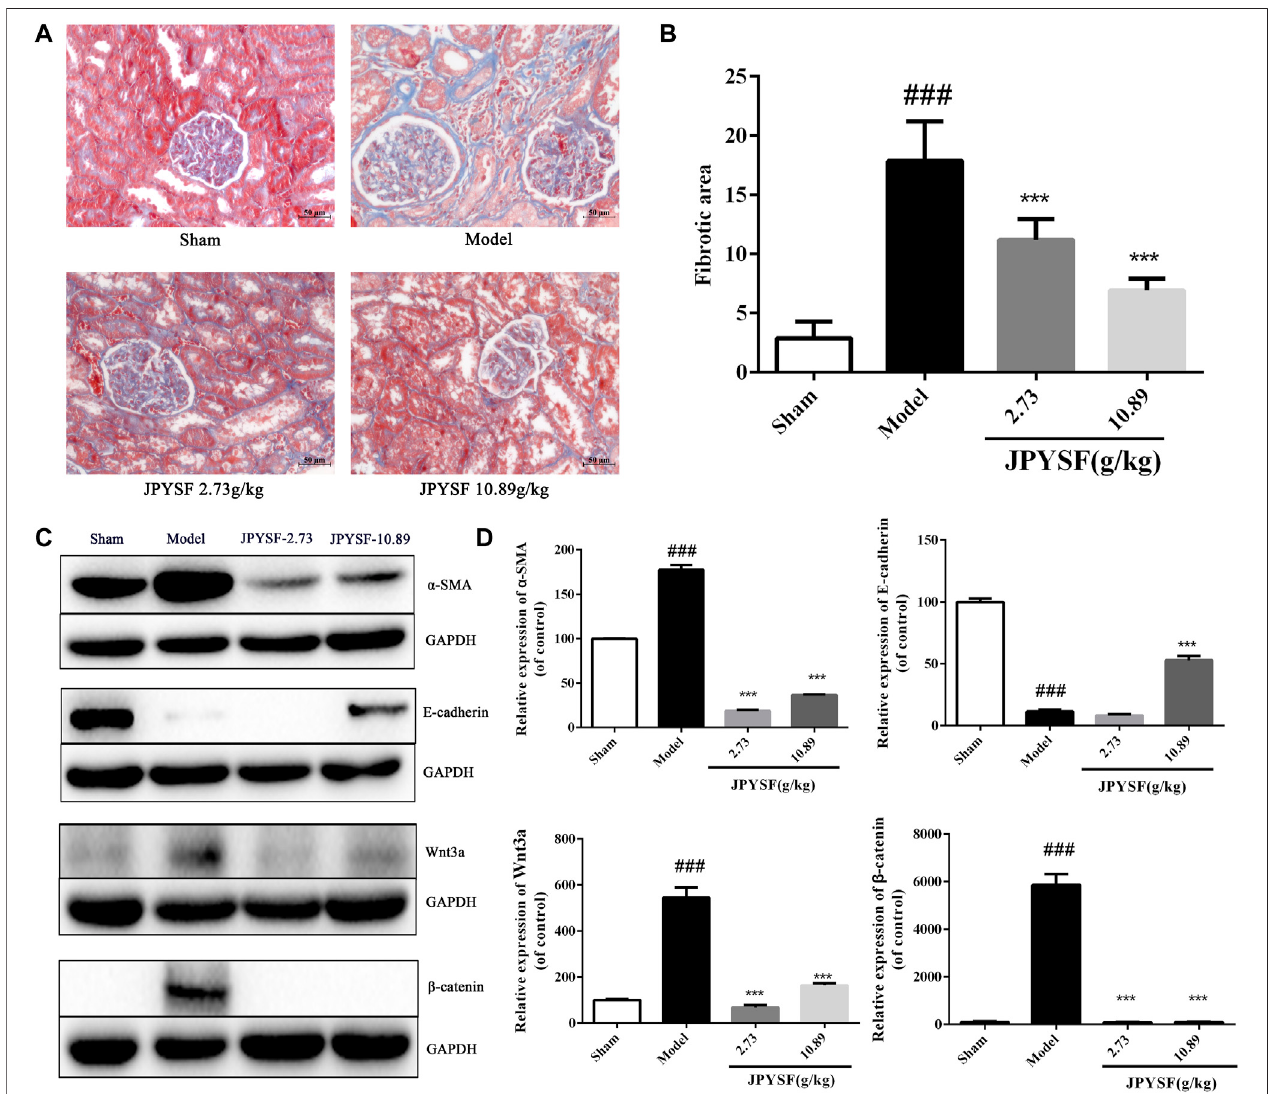
FIGURE 6 | JPYSF administration signi fi cantly reduces renal fi brosis by alleviating EMT in 5/6 nephrectomy (Nx) rats. (A) Representative images of renal tissue are shown by Masson staining from the sham group, model group, the JPYSF 2.73 g/kg group, and the JPYSF 10.89 g/kg group (200×). (B) Quantitative analysis of the fi brotic area. Data were presented as the mean ± SEM, n = 10 rats per group ( ### , p < 0.001, compared with the sham group; ***, p < 0.001, compared with the model group). (C) Relative protein expression of α -SMA,E-cadherin, Wnt3a, and β -catenin inthe kidney cortex tissues ofthesham, model, 2.73, and 10.89 g/kg Jian-Pi- Yi-Shen formula (JPYSF) groups by western blot analysis. Representative bands show the relative expression of α -SMA, E-cadherin, Wnt3a, and β -catenin. (D) Quantitative analysisofprotein expressionsof α -SMA,E-cadherin, Wnt3a, and β -catenin bydensitometrybased onwesternblot images. ### , p < 0.001, compared with the Sham group; ***, p < 0.001, compared with the model